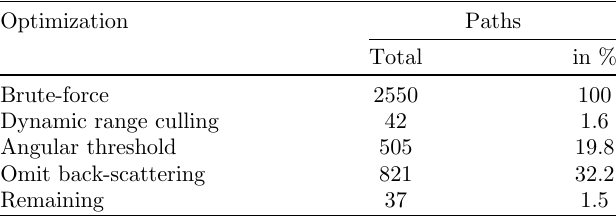
Table 2. Absolute and relative number of found paths with re fl ection and diffraction components for each scenario without and with path-number reducing optimizations.